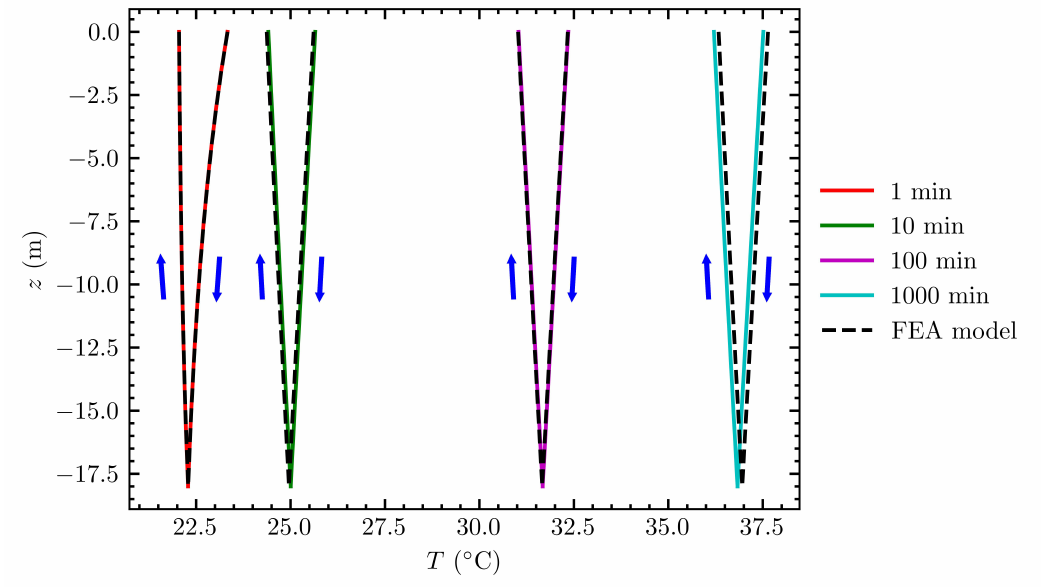
Figure 7. Fluid temperature profiles along pipes at 4 different